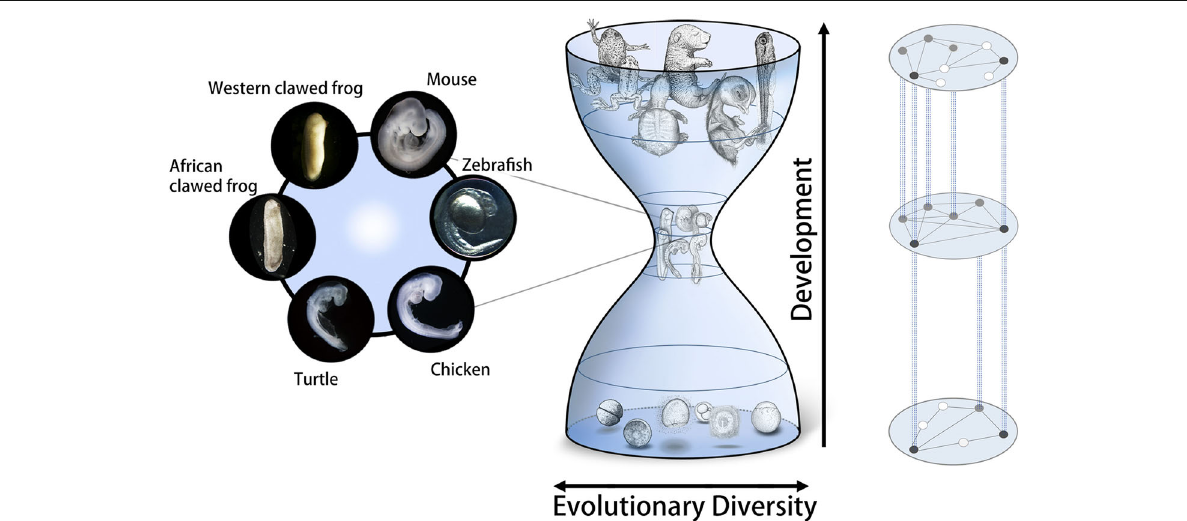
Fig. 5 The developmental hourglass model and embryos representative of phylotypic periods in vertebrates. In the developmental hourglass model (middle, originally proposed by Duboule [64]), embryogenesis proceeds from the bottom to the top, and evolutionary divergence becomes minimal at the mid-embryonic, organogenesis phase. The conserved mid-embryonic phase has been predicted to define the body plan for each animal phylum [64] and has therefore been named the phylotypic satage [64, 65, 66, 181]. However, further studies are required to fully verify this hypothesis, and a recent study indicated that the hypothesis may be better applied to vertebrates than to chordates [63]. Embryos representative of most conserved vertebrate stages are shown at the left. Curiously, these stages can also be identified as the most conserved stages when comparing groups of species smaller than at the vertebrate level. No consensus has been reached on the mechanism of this mid-embryonic conservation, but two independent studies have implied possible contributions by developmental constraints [63, 74]. In other words, extensive reuse of the same genetic machinery could have imposed limitations on the evolutionary diversification process through pleiotropic constraint (right, modified from Hu et al. [63]). In each developmental stage, grey and black dots represent genetic components that are pleiotropically expressed in other stages and are shared (blue vertical lines) by multiple developmental